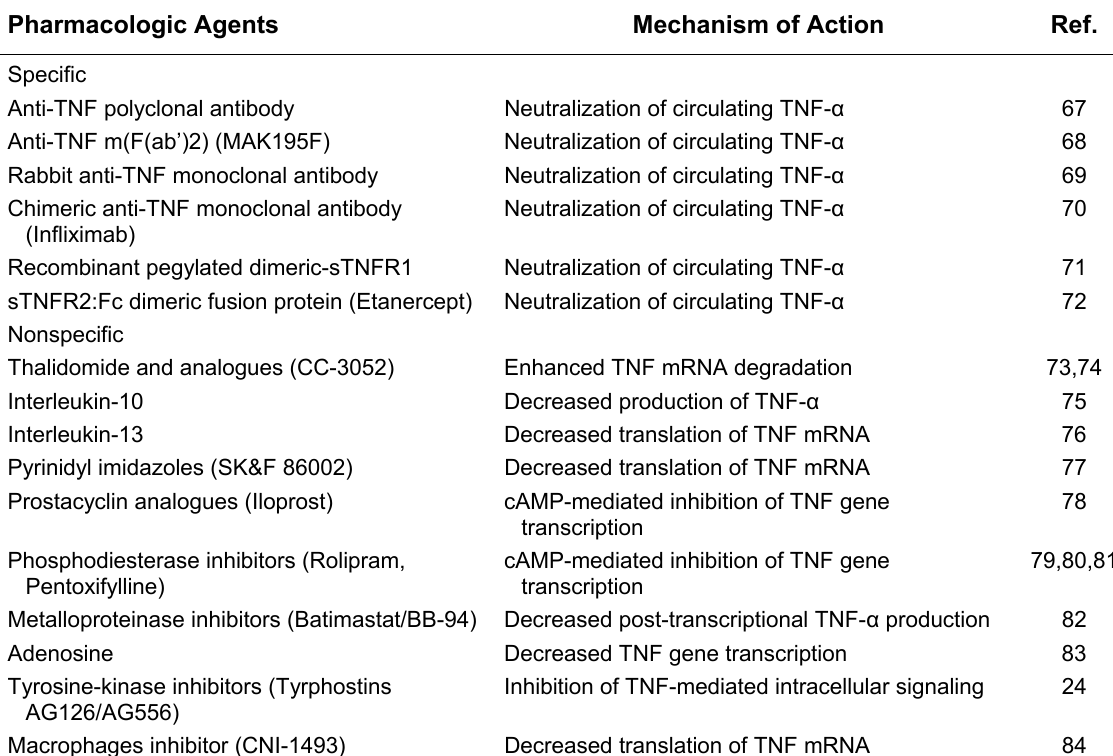
Specific and Nonspecific Pharmacologic Agents Targeting TNF-